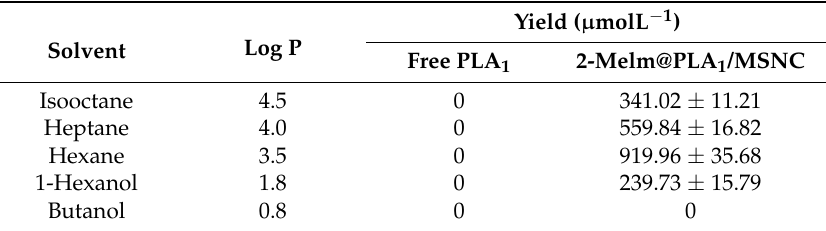
Table 1. Effects of organic solvents on the L- α -glycerylphosphorylcholine (L- α -GPC) yield catalyzed by 2-Melm@PLA 1 /MSNC and freePLA 1 .